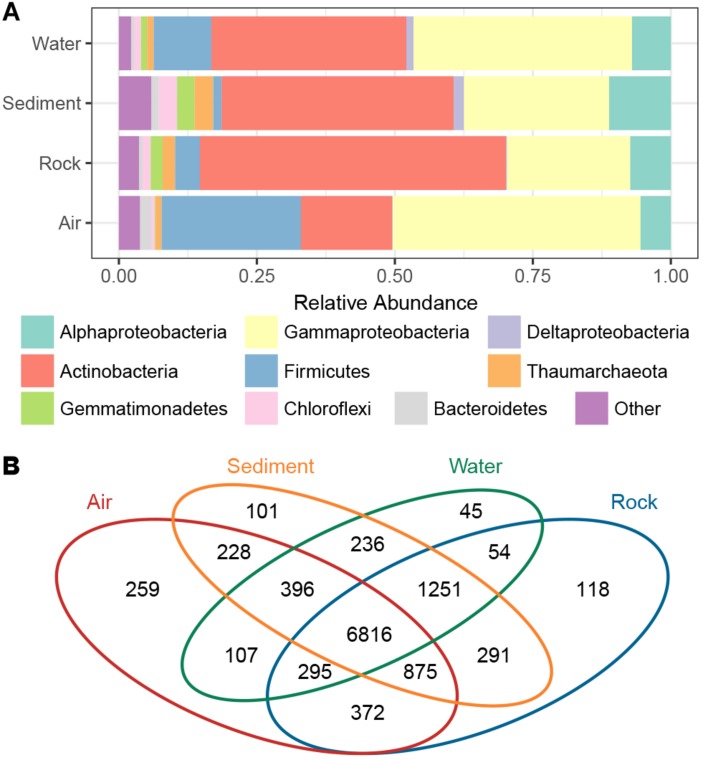
The proportion of bacterial phyla/subphyla in the four cave niches (A). Venn diagram of the exclusive and shared OTUs found among the different cave niches (B).